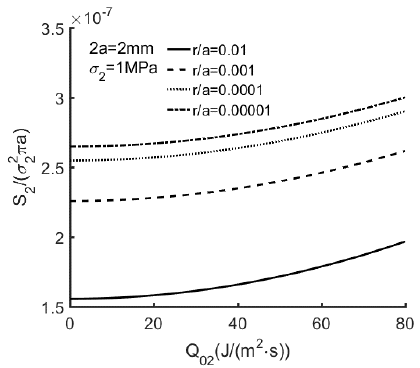
Figure 10. S 2 / ( σ 22 π a ) versus 𝑄 02 with 𝑟/𝑎 = 0.01,0.001,0.0001 ， 0.00001 for 𝜛 𝑐 = 0 and 𝜀 = 0.01.